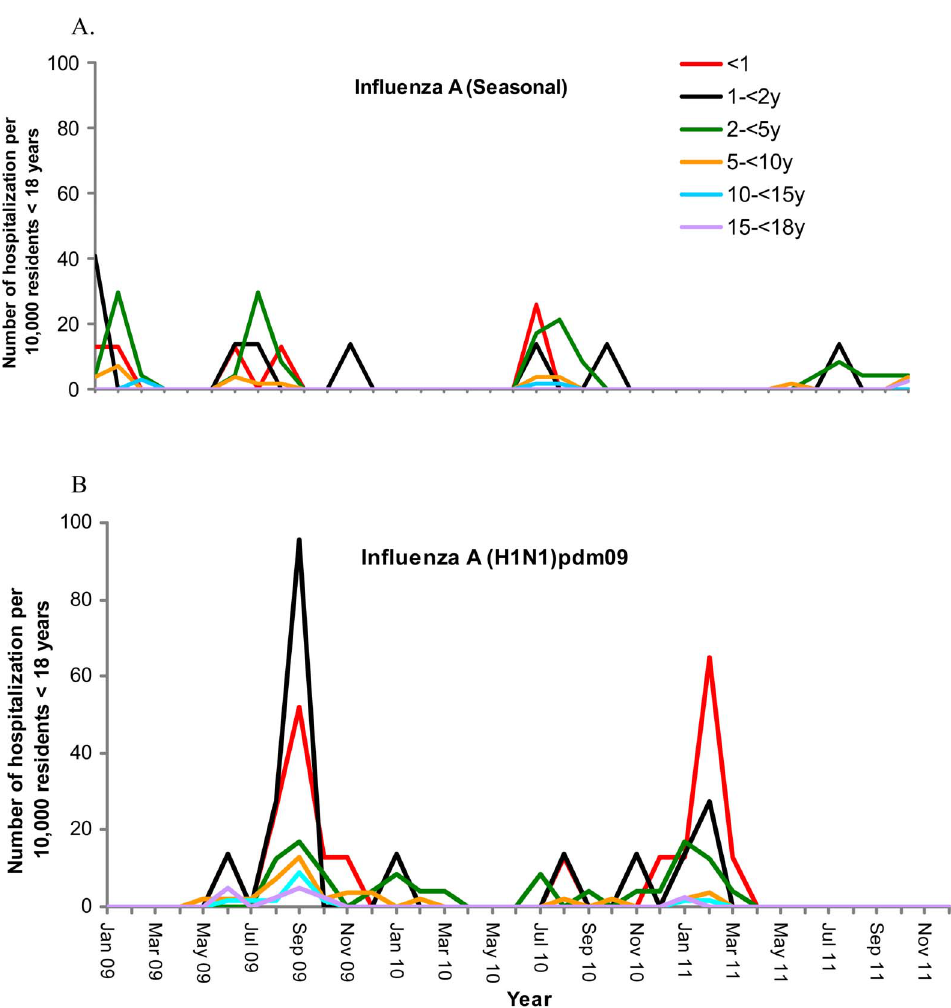
Figure 2. A & B. Age-specific hospitalization rates for seasonal influenza A and H1N1pdm09 (2009–2011).